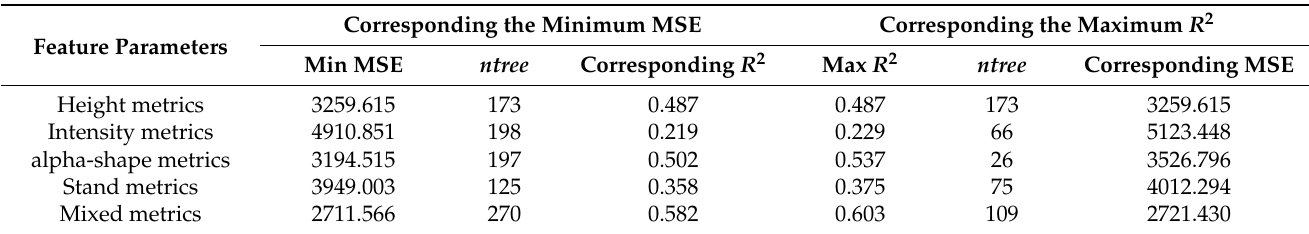
Table 7. The optimal parameters for each of the random forest model corresponding